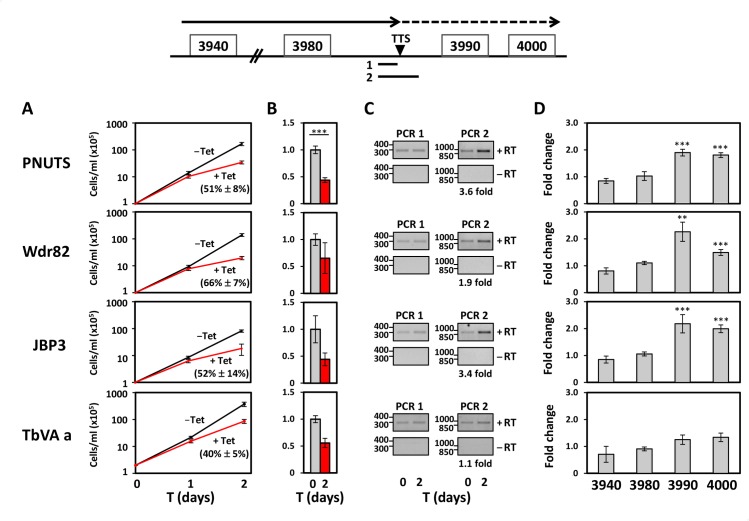
PNUTS, Wdr82 and JBP3 are involved in Pol II transcription termination in T. brucei.(A) PNUTS, JBP3 and Wdr82 are essential for cell viability of the infectious BSF T. brucei. Cell growth was arrested upon PNUTS, JBP3 and Wdr82 mRNA ablation by RNAi. VA a; acidocalcisome VA a protein. Reduction in cell growth rates upon mRNA ablation between day 1–2 are indicated. (B) Depletion of mRNA upon Tet induction of RNAi by qRT-PCR analysis. Results are arithmetic mean with error bars showing standard deviation from three biological replicates analyzed in triplicate. P values were calculated using Student’s t test. ***, p value ≤ 0.001. (C and D) Analysis of Pol II termination. Above; Schematic representation of a termination site on chromosome 5 where Pol II has been shown to terminate prior to the last two genes (Tb927.5.3990 and Tb927.5.4000) in the PTU. The dashed arrow indicates readthrough transcription past the TTS that is regulated by base J and H3.V. Solid lines below indicate regions (1 and 2) analyzed by RT-PCR. (C) RT-PCR analysis of nascent RNA. cDNA was synthesized using random hexamers and PCR was performed using the appropriate reverse primer for each region (1 and 2) plus an identical forward primer. A minus-RT control (-RT) is included. Quantitation (fold upregulation) of the PCR products for region 2 of the indicated gels using Gel Doc Quantity One software is provided below. (D) RT-qPCR analysis of genes numbered according to the ORF map above. Transcripts were normalized against Asf1 (which represents a PTU internal Pol II transcribed single copy gene as a negative control), and are plotted as the average and standard deviation of three biological replicates analyzed in triplicate. P values were calculated using Student’s t test. **, p value ≤ 0.01; ***, p value ≤ 0.001. RT-PCR products for genes 3990 and 4000 were confirmed by cloning and sequencing of multiple clones.